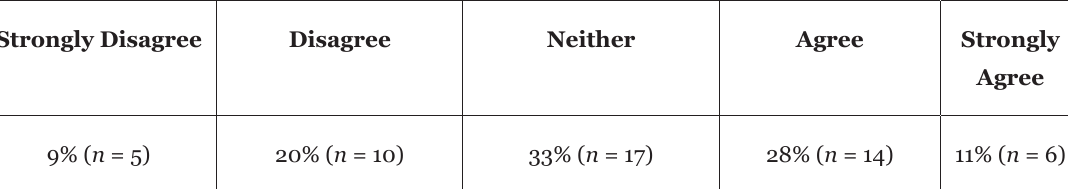
Responses to the Question about Understanding why the University was Moving to a New